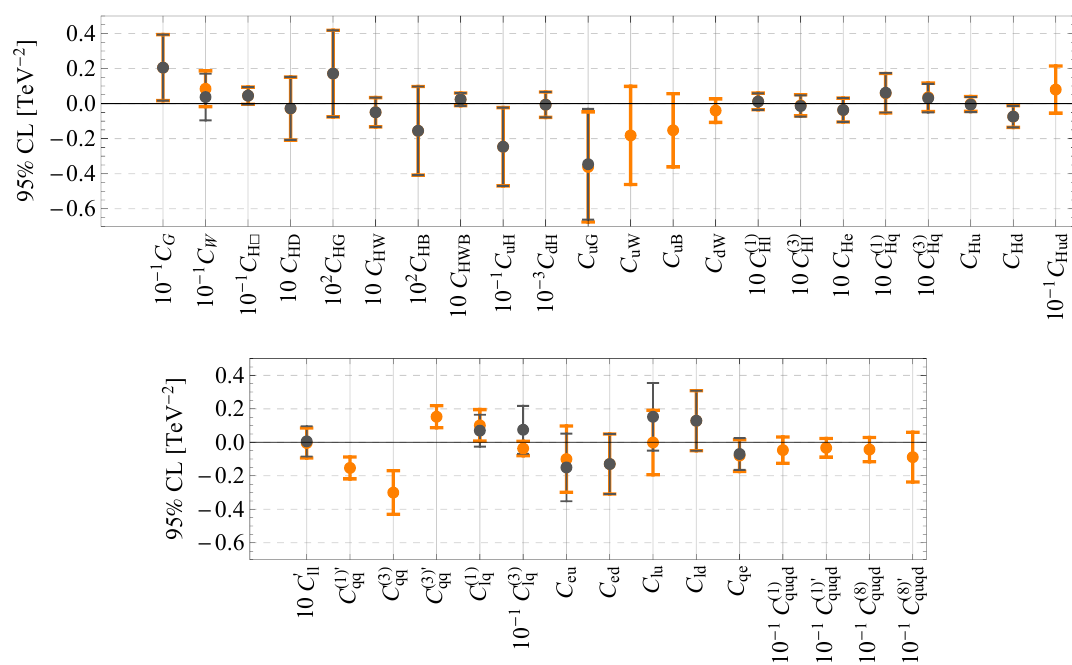
Figure 6. Constraints (at 95% confidence level) obtained when allowing only one Warsaw basis operator to be non-zero at a time. In black are the bounds from the fit not including flavour data, and in orange are the bounds from the fit including flavour data. Note the different normalisations of the coefficients along the x -axis; this was done for presentation